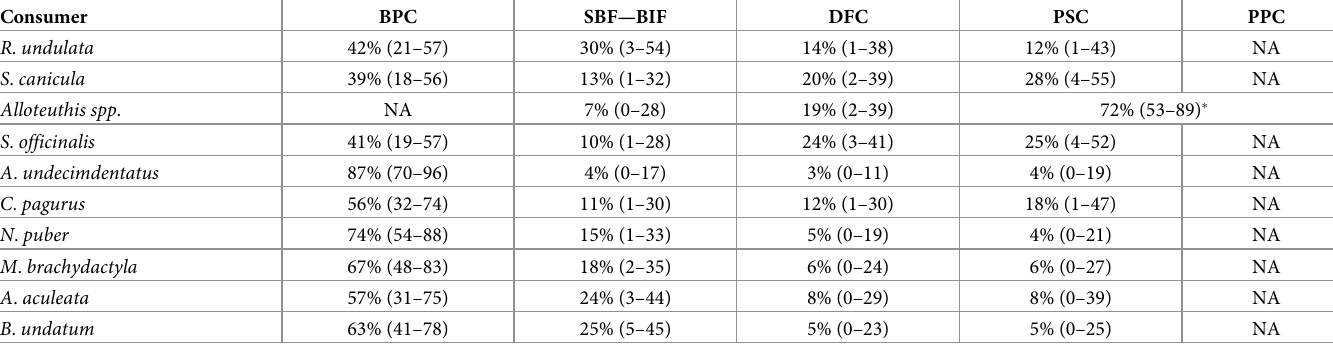
Table 2. Stable isotope mixing models depicting the assimilated diet of 10 taxa with prior knowledge of important discard ingestion in the Bay of Biscay (France). Food sources were combined in 6 groups a priori using a hierarchical clustering approach: BPC = Benthic primary consumers, SBF = Shrimps and benthic fish, BIF = Benthic invertebrates and fish, DFC = Demersal fish and cephalopods, PPC = Pelagic primary consumers and PSC = Pelagic secondary consumers. Contributions are presented as mode and 95% credible intervals of diet proportions. NA = source not included in the model. See Material and methods and Table 1 for the list of taxa included within each food source